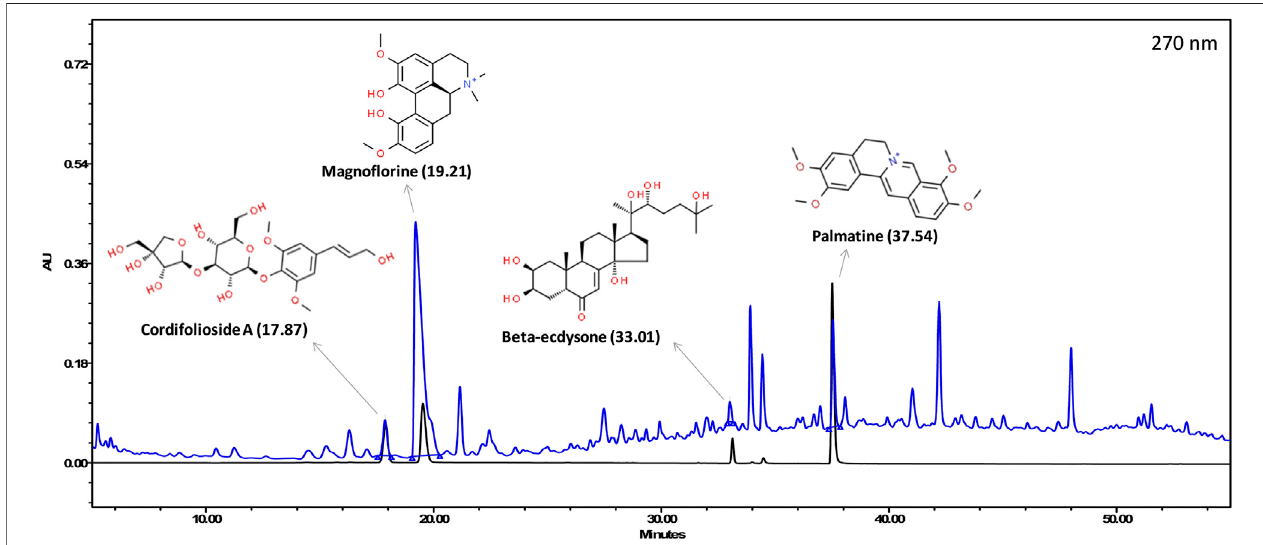
FIGURE 2 | HPLC pro fi le showing an overlap of Giloy Ghanvati aqueous extract (blue chromatogram) and a mixture of standards (black chromatogram). The structures of the phyto-compounds and their retention time are